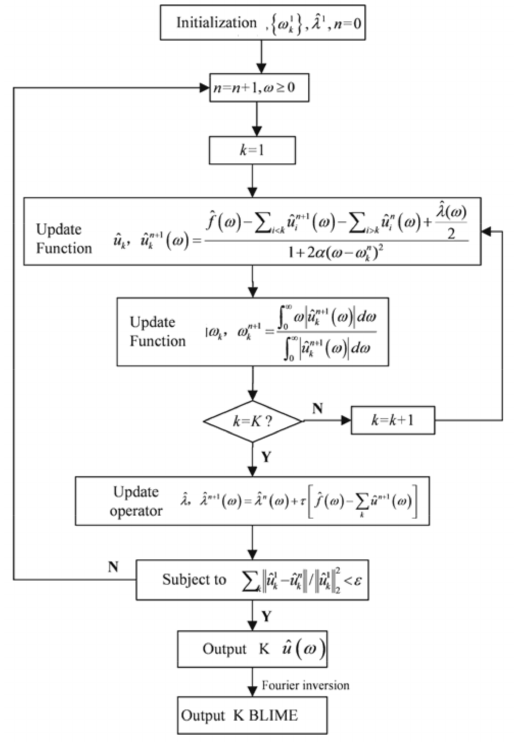
Figure 1. The flow charts of variational mode decomposition